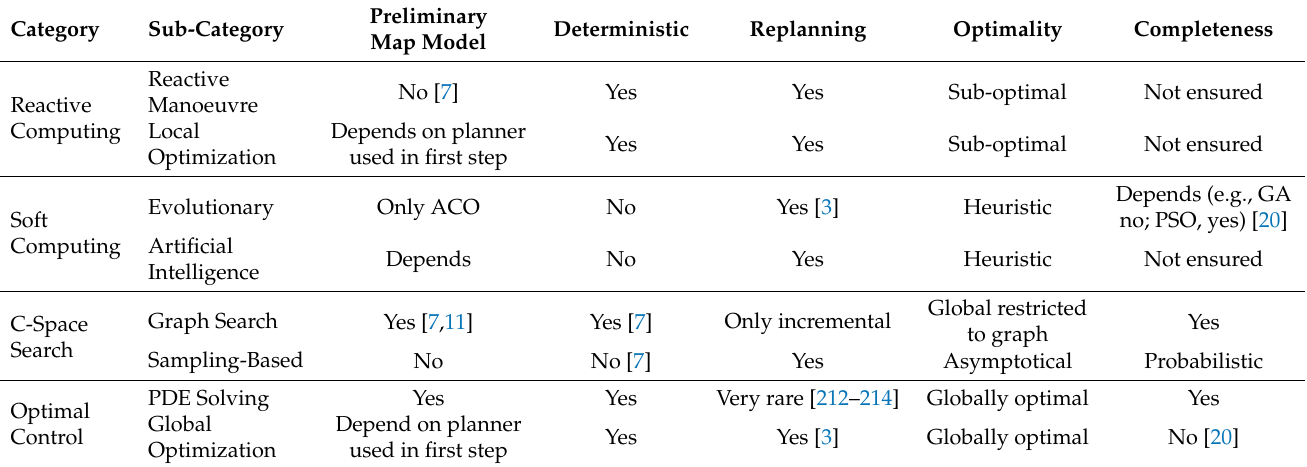
Table 3. Overview of characteristics of the presented path planning